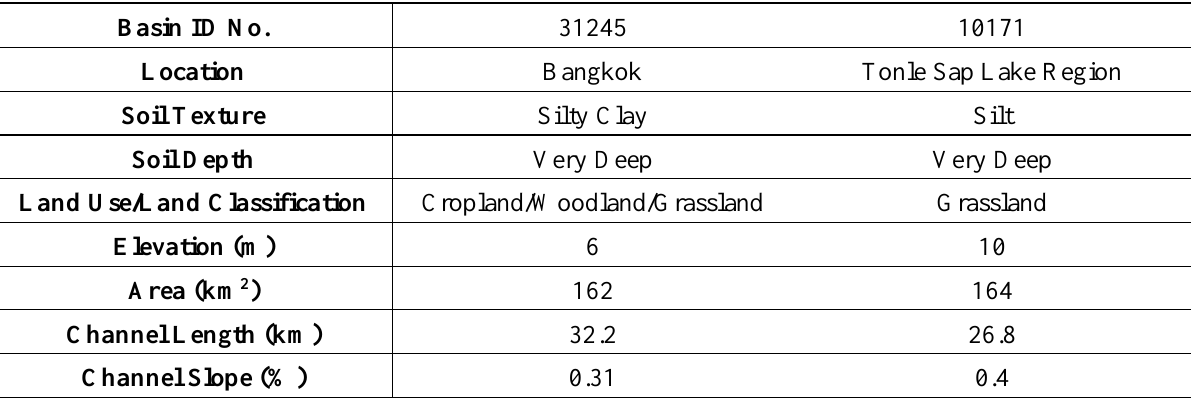
Table 1. Case study basin characteristics.